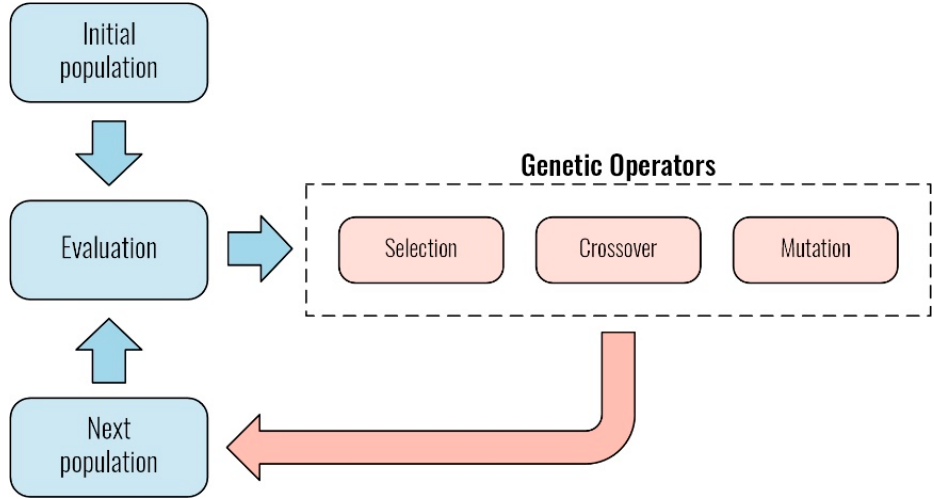
Figure 1. GA general scheme.